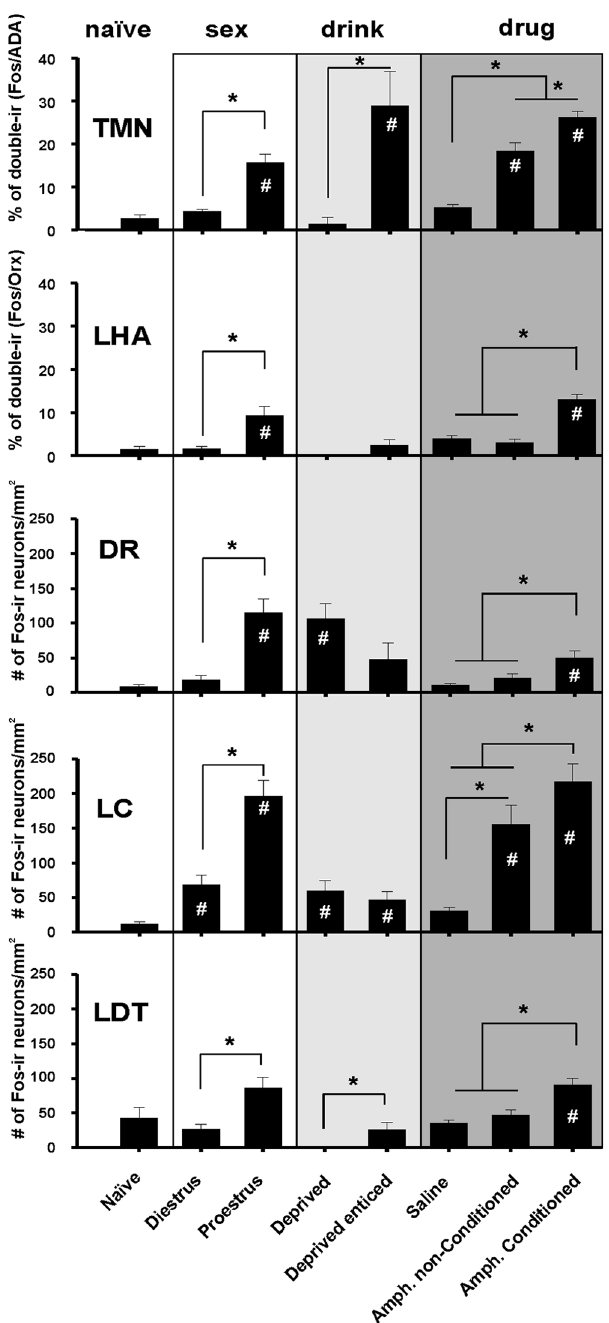
Fig 1. Fos-ir pattern of AAS nuclei elicited by appetitive behavior. Left column in white (sex): Fos-ir after 30 min of exposure to receptive (proestrus n = 5) or to non-receptive (diestrus n = 5) females. Middle panel in light gray (drink): 48 hours of water deprivation followed by 30 minutes of enticing (Deprived enticed n = 14) or not (Deprived n = 6). Right column in dark gray (drug): 30 minutes of exposure to the place preference apparatus where the animals were conditioned to amphetamine (Amph. Conditioned), versus non- conditioned animals (Amph. non-Conditioned) and rats non-conditioned injected with saline, (saline). # p < 0.05 respect to the na ï ve circadian controls; * p < 0.05 between conditions. Kruskall Wallis one way ANOVA followed by all pairwise multiple comparisons (Dunn's Method).